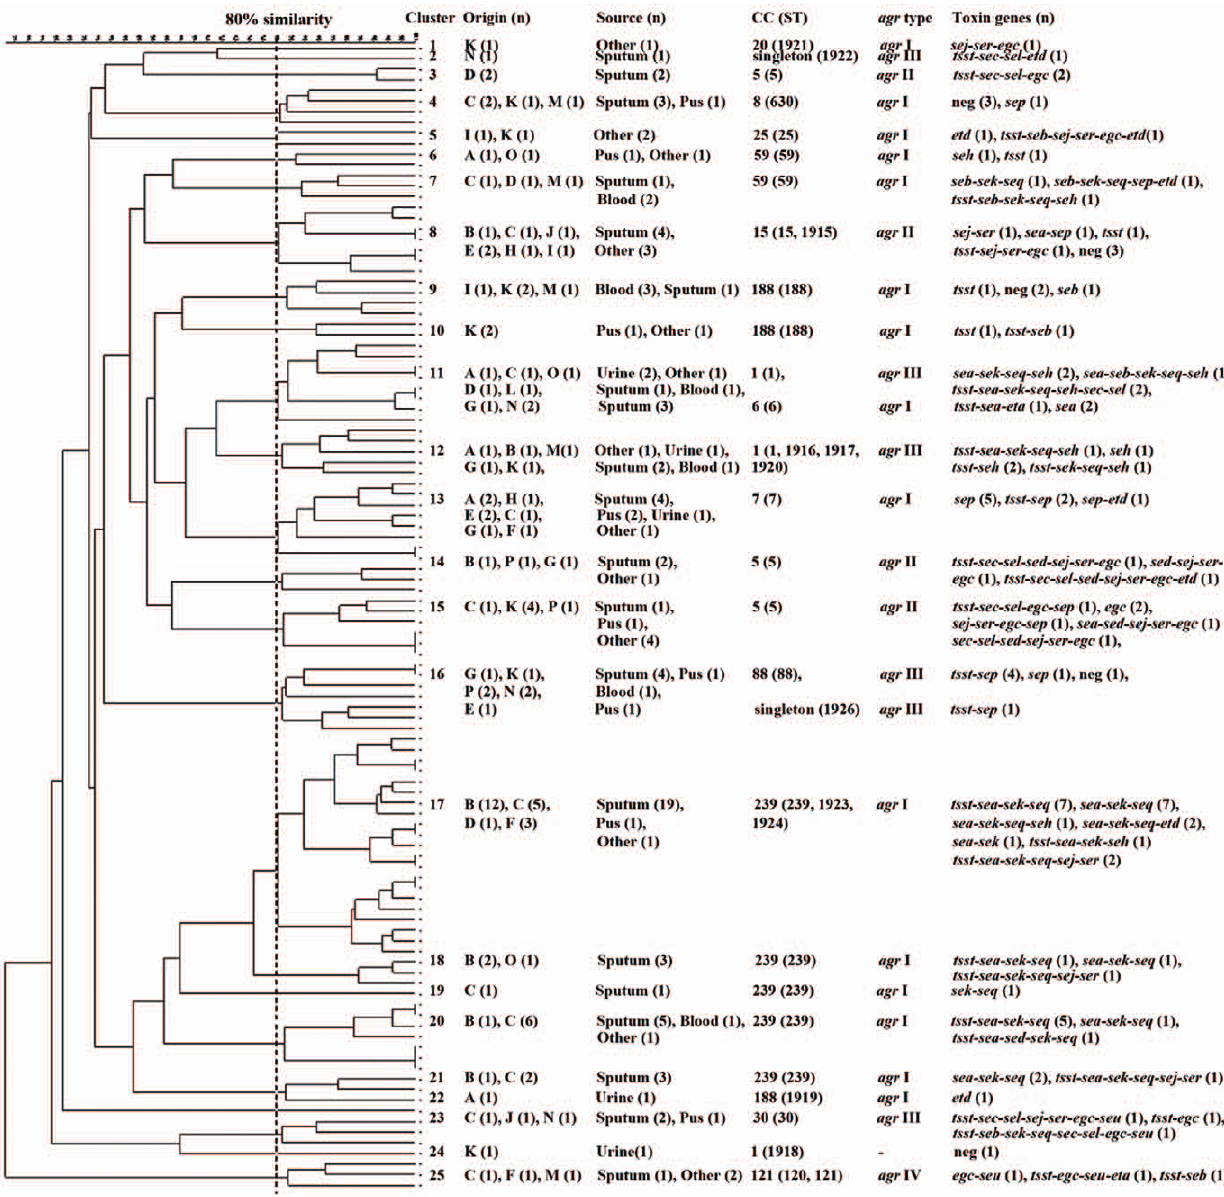
Figure 2. Dendrogram of PFGE clusters and genotypic relationships of S.aureus isolates. Based on PFGE patterns, 108 clinical isolates were grouped into 25 clusters. In each cluster, the hospital origins, clinical sample sources, MLST clonal complexes, agr types, and toxin gene contents of the strains are listed. egc : seg-sei-sem-sen-seo and neg: negative for toxin genes. doi:10.1371/journal.pone.0028276.g002 PLoS ONE |